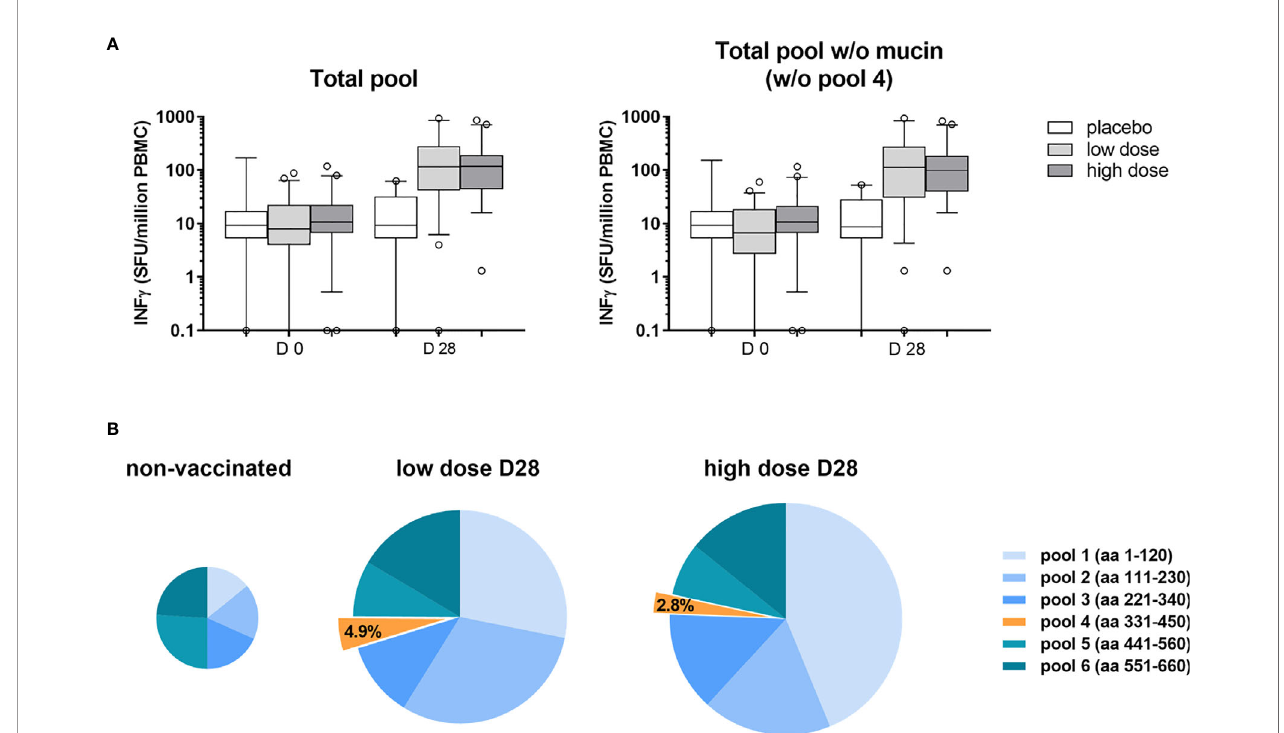
FIGURE 1 | The mucin-like domain was poorly immunogenic for ChAd3-EBOZ volunteers. T-cell Elispot performed on sera from volunteers of the Lausanne clinical trial, whose T-cells were stimulated with a pool of 15-mers overlapping peptides covering the entire sequence of the GP protein [ (A) left graph] or the same pool without the region corresponding to the mucin-like domain [ (A) , right graph]. Analysis was performed before vaccination (D0) or 28 days after vaccination (D28) in the placebo group, as well as in the groups of volunteers immunized with the ChAd3-EBOZ vaccine at low dose or high dose. In (B) the contribution of each pool to T-cells stimulation is highlighted. Information about the GP region covered by each pool are reported in the fi gure. The size of the pies correlates with